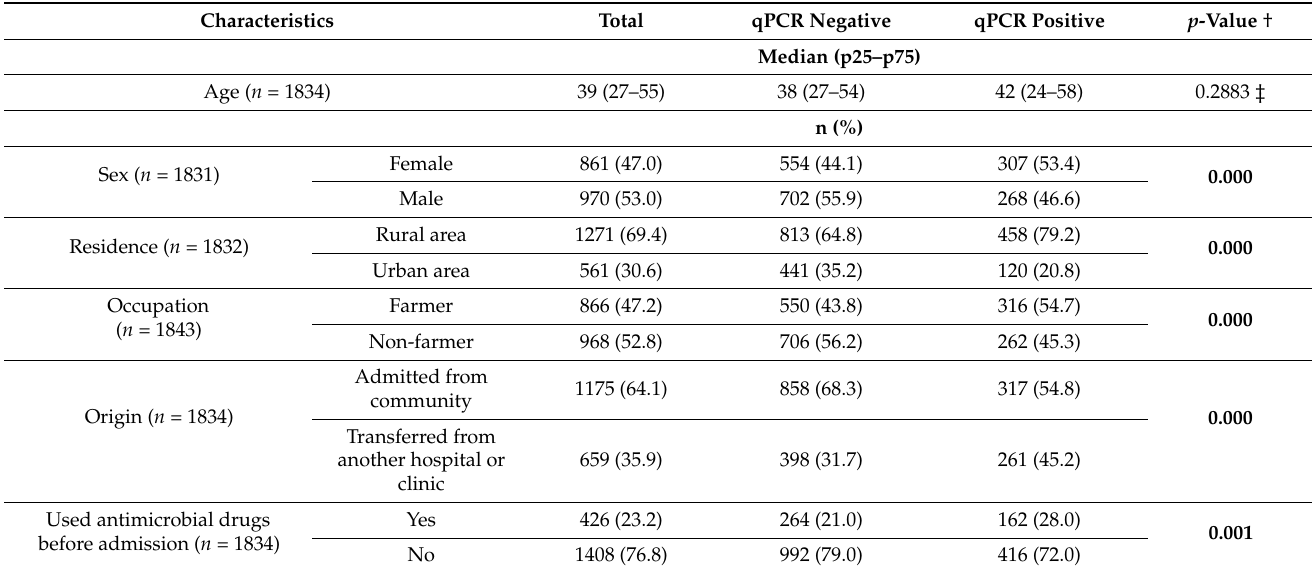
Table 1. General characteristics of patients enrolled in the